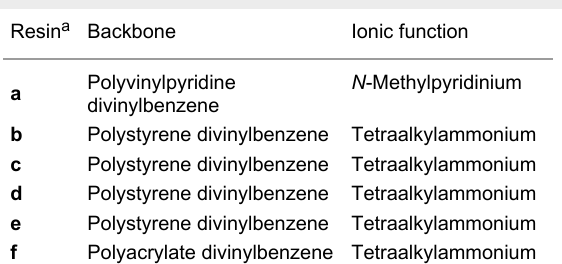
Table 2: Polymeric backbones and functionalities of the different strongly basic anion exchange resins used for batch adsorption